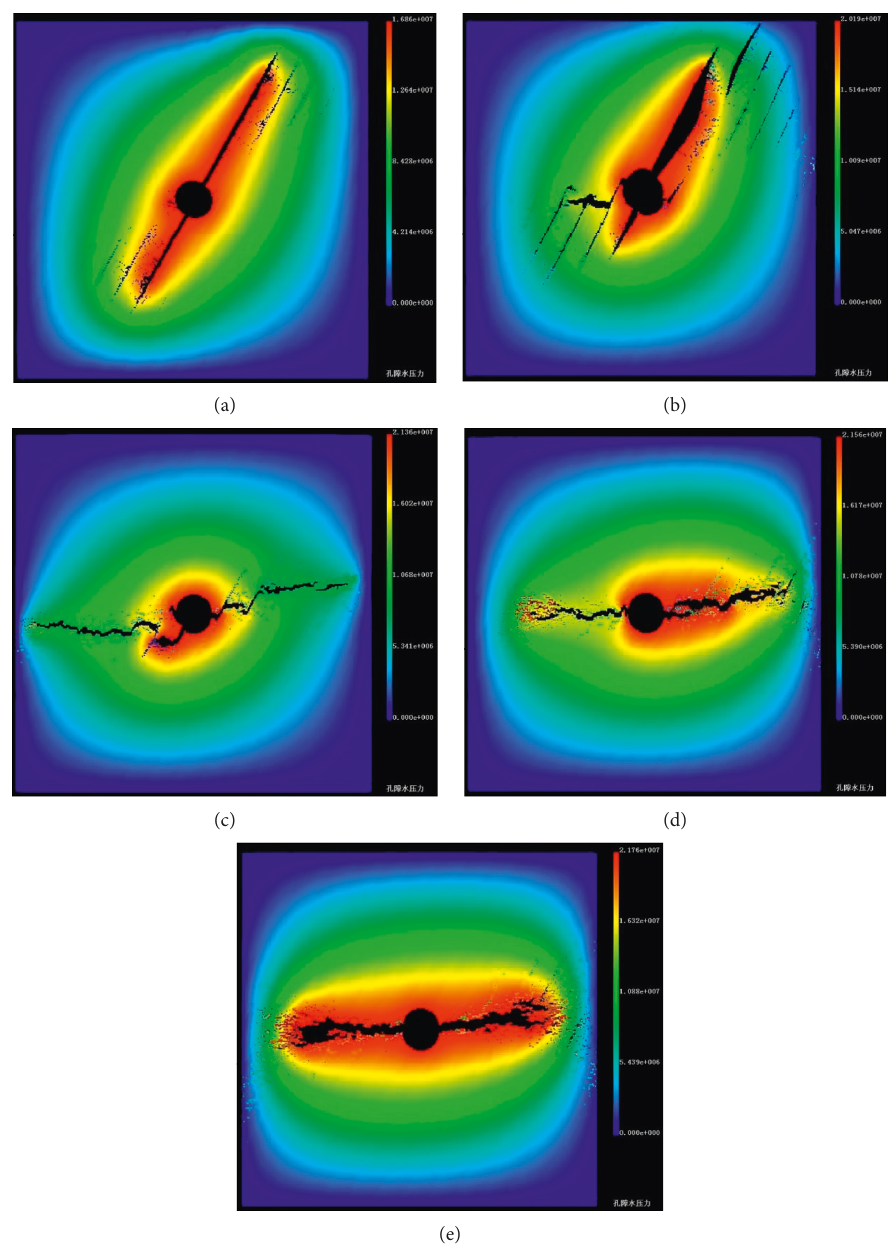
Figure 10: Pore pressure field of joint strength models. (a) f